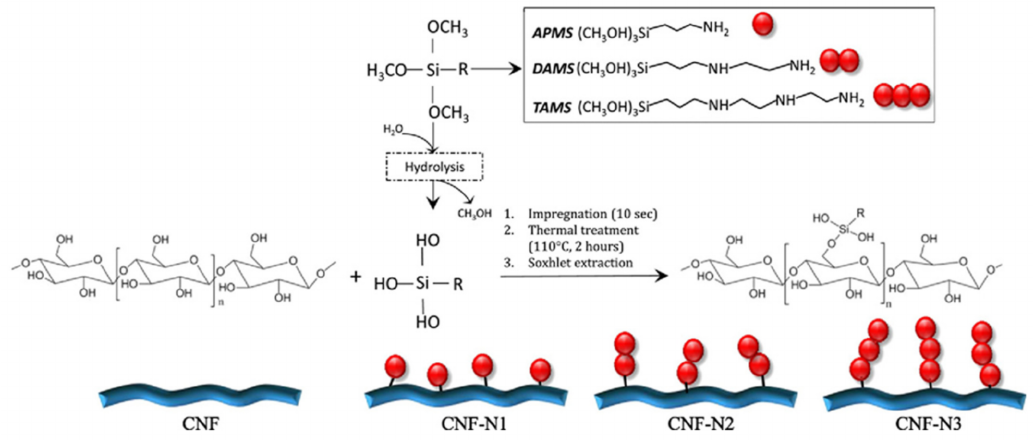
Figure 6. Schematic illustration of the mechanism for aqueous-based silylation reaction with amino silanes on the surface of cellulose nanofibers films (Saini et al. [63]; with permission from Elsevier Science Ltd., Amsterdam,